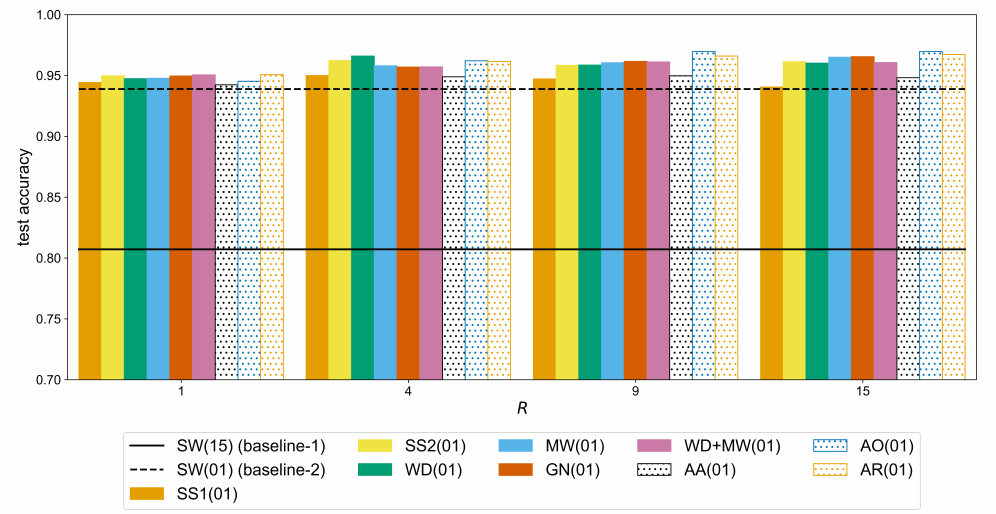
Figure A5. Average test accuracy of AtzoriNet* for each method at different augmentation ratios, R , for the putEMG dataset. The solid line corresponds to τ = 15 and the dashed line to τ = 1 (see also Figure